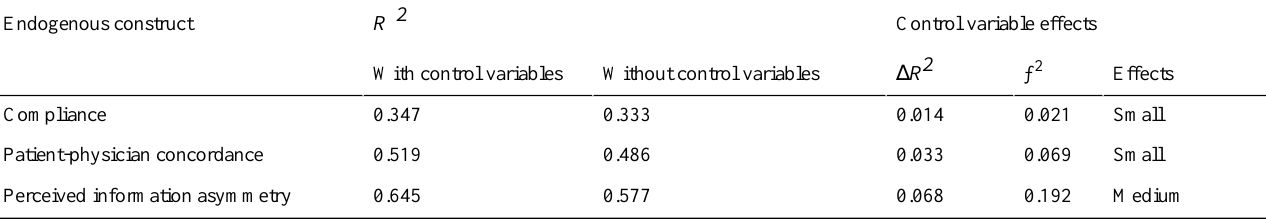
Table 2. Multivariate coefficient of determination ( R2 ) results.